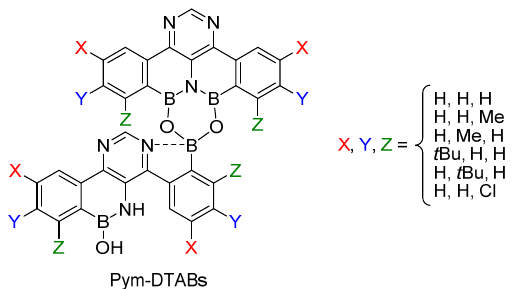
Figure 2. Pym ‐ DTAB structure.